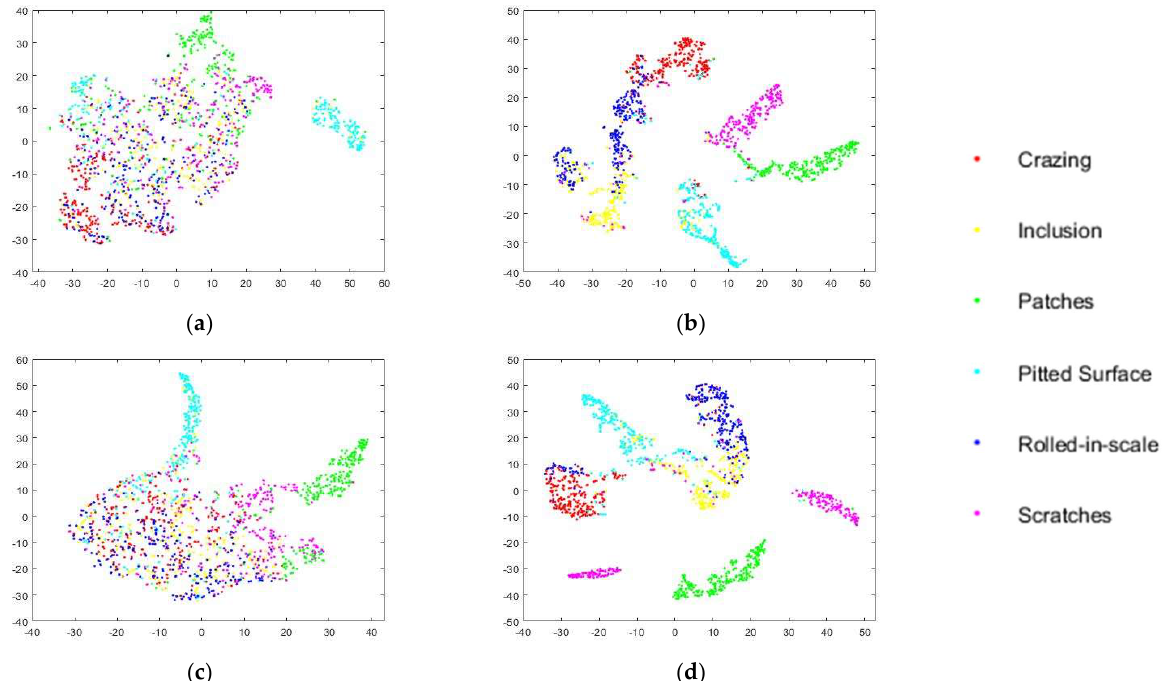
Figure 7. Feature visualization via t-SNE on Gaussian white noise (Variance 0.3). The feature vectors are extracted from the activations of the fully connected layer. ( a ) The original level 0 model. ( b ) The retrained level 0 model. ( c ) The original level 1 model. ( d ) The retrained level 1 model.